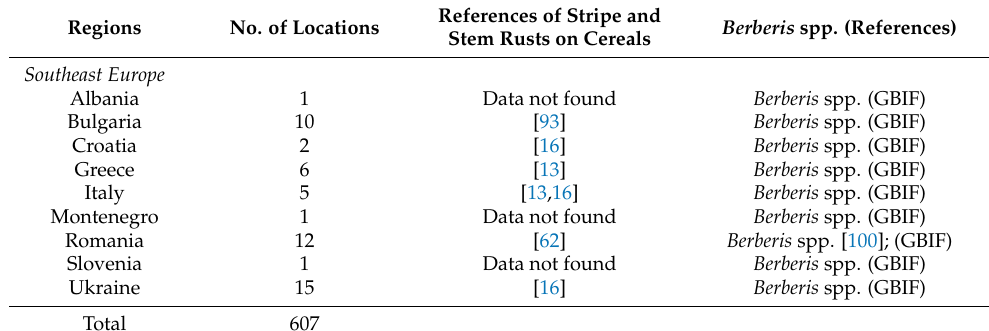
Table 3. Cont. Regions No. of Locations